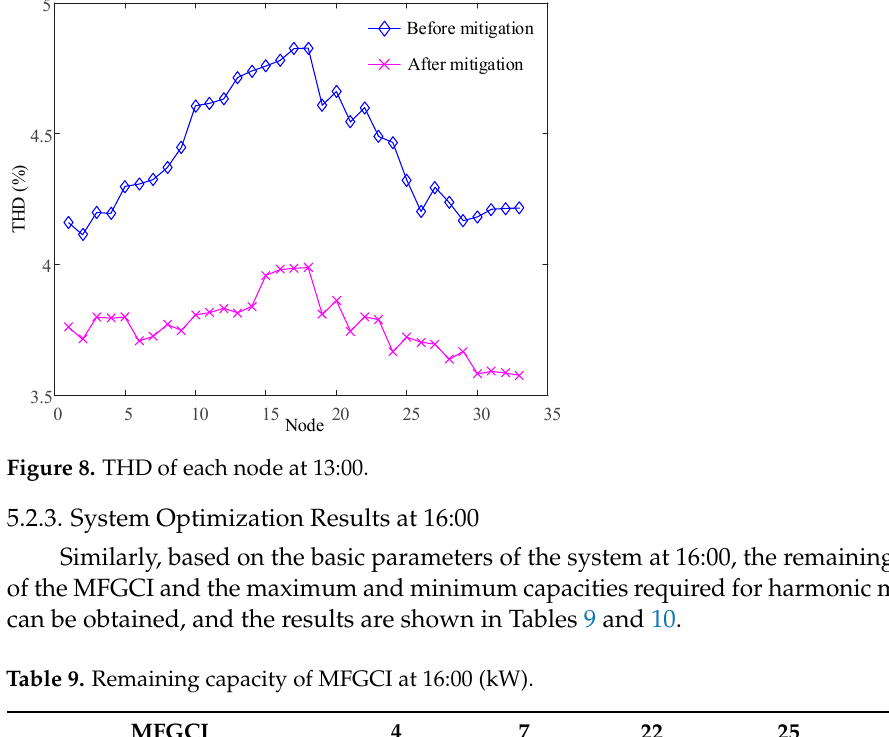
Table 9. Remaining capacity of MFGCI at 16:00 (kW).